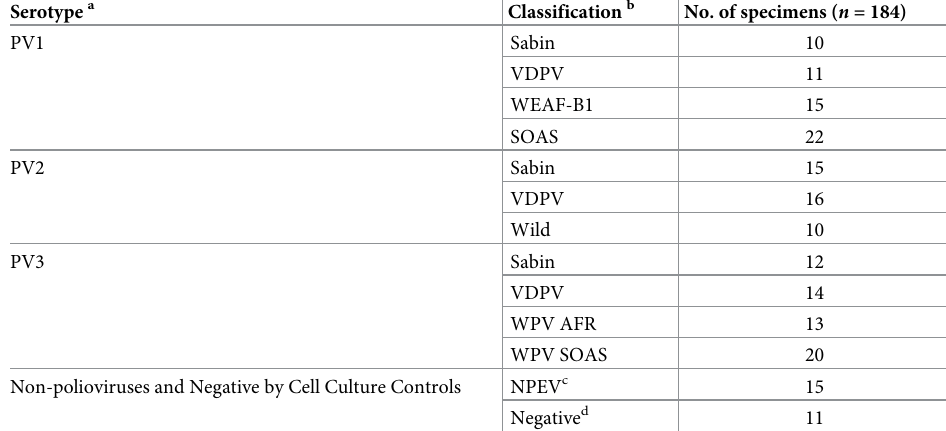
Table 1. Summary of poliovirus, non-poliovirus and non-enterovirus isolates by serotype and genotype tested at the polio laboratory at CDC, Atlanta. Serotype a